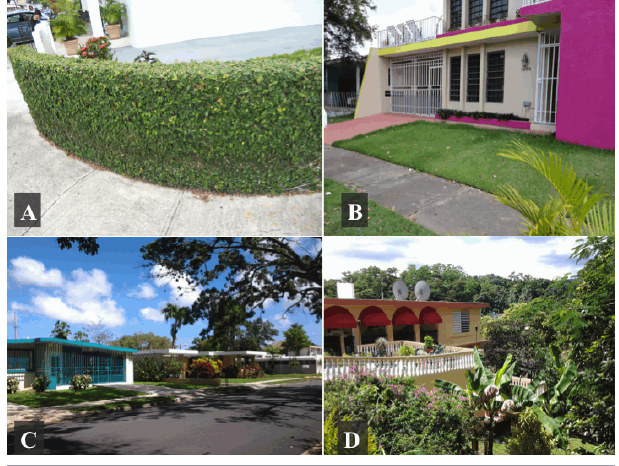
Fig. 2 . Examples of the variety of yardscapes observed within the Rio Piedras watershed and associated with single-housing units at each study. (A) Over-paved front yard, Puerto Nuevo. (B) Mostly lawn, front yard, Avenida Central. (C) Mixed shrubs and trees, La Sierra. (D) Highly forested yards,